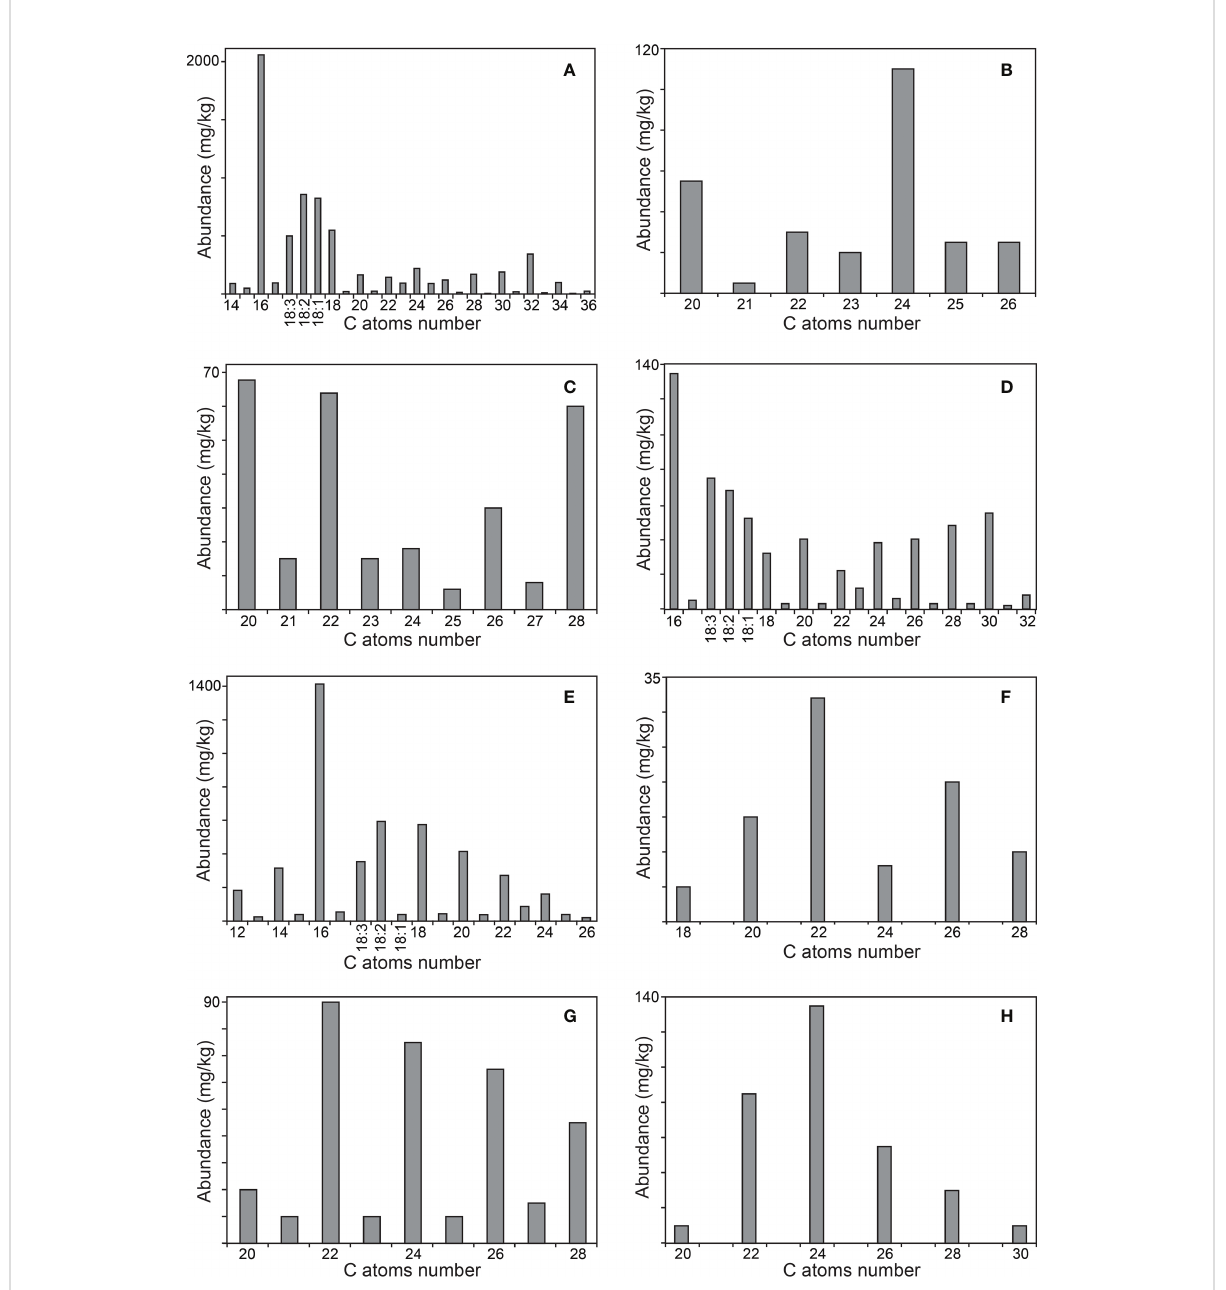
FIGURE 6 Distribution of the main aliphatic series identi fi ed in the acetone extracts of the rind of papyrus stems. (A) n -fatty acids; (B) 2-hydroxy fatty acids; (C) n -fatty alcohols; (D) 1-monoglycerides; (E) phytol esters; (F) alkyl ferulates; (G) w -carboxyalkyl ferulates; (H) monoglycerides of w - carboxyalkyl ferulates. The histograms are scaled up to the abundance of the major compound in the